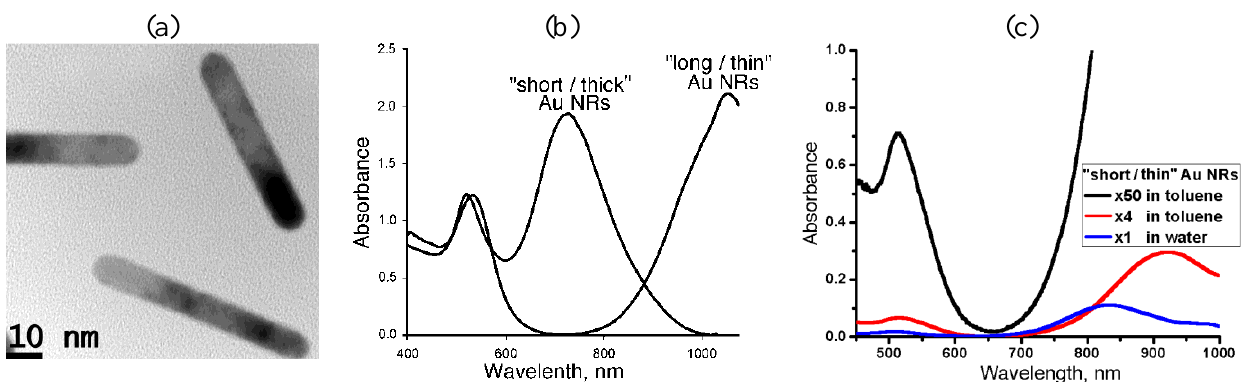
(blue line), as well as toluene 𝑤𝑎𝑡𝑒𝑟 (red line) and 50 𝜂 (black line) (c) 𝑤𝑎𝑡𝑒𝑟 𝑤𝑎𝑡𝑒𝑟